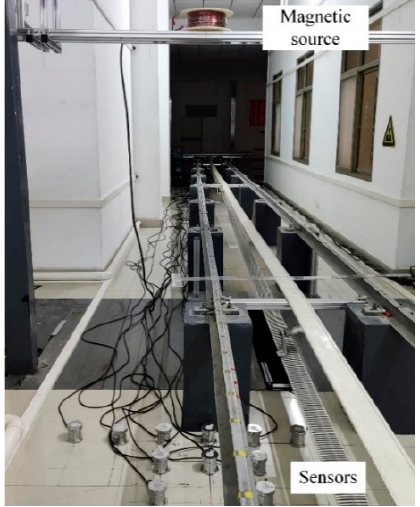
Figure 5. The experimental setup for the localization of the magnetic